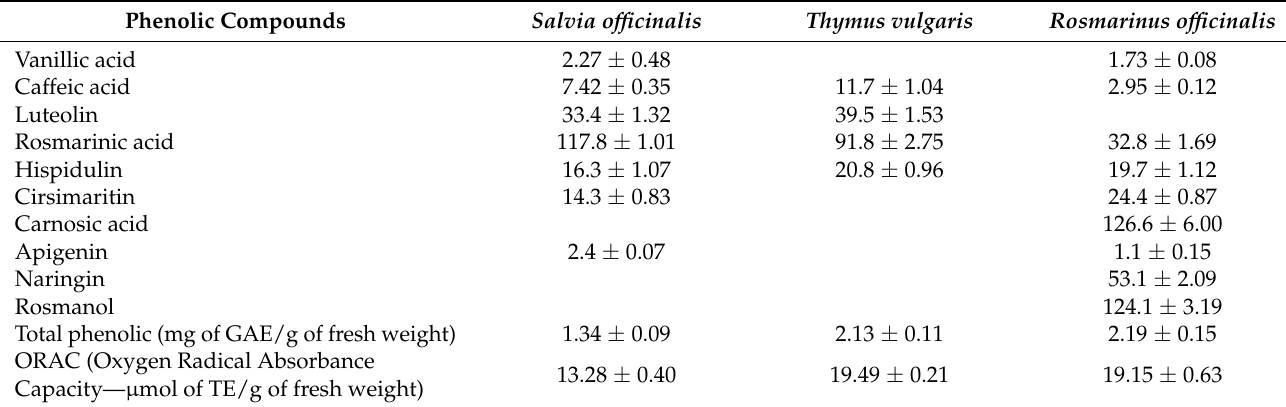
Table 1. Phenolic compounds in Salvia officinalis , Thymus vulgaris , and Rosmarinus officinalis (mg/100 g of fresh weight). Data from Zheng and Wang [22].